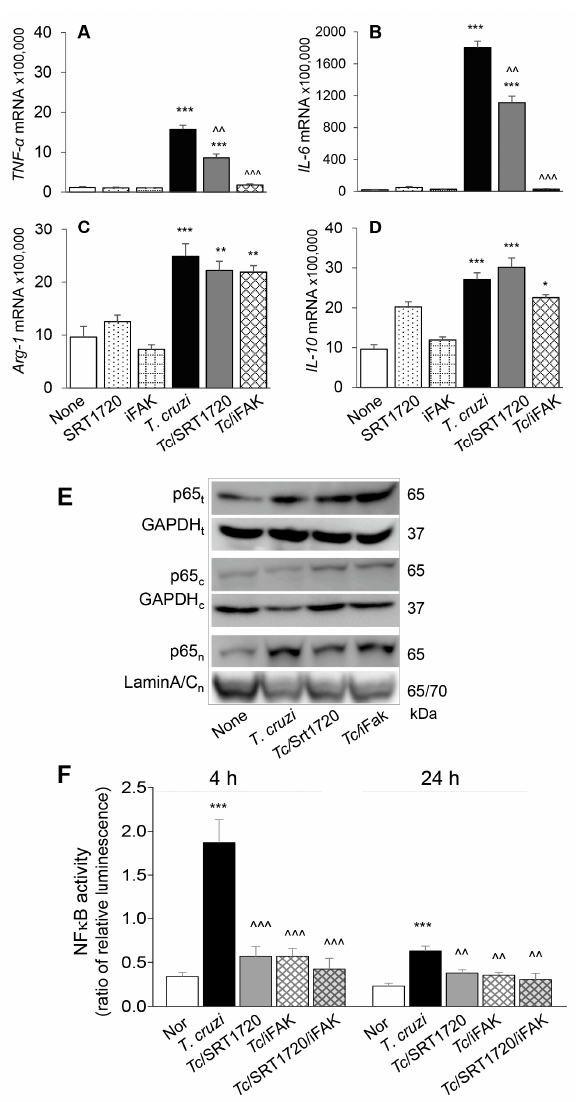
Figure 7. SIRT1-FAK (Sirtuin 1-focal adhesion kinase) regulate nuclear translocation of P65, NF- κ B activity, and cytokines’ gene expression in M ϕ infected by T. cruzi . ( A – D ) RAW 264.7 M ϕ were incubated for 24 h with T. cruzi trypomastigotes (cell parasite ratio, 1: 3) in absence or presence of SRT1720 (1 µ M) or inhibitor of FAK (iFAK, 10 µ M). Gene expression analysis of TNF- α (A), IL-6 ( B ), IL-10 ( C ) and Arg-1 ( D ) was performed by real-time RT-qPCR, and Ct values for target genes were normalized to GAPDH expression (three biological replicates per group, duplicate observations per sample). ( E ) RAW 264.7 M ϕ were infected and treated with SRT1720 or FAK inhibitor, as above. Shown are representative immunoblots for NF κ B p65 subunit in total (t) cell homogenates, and cytosolic (c) and nuclear (n) fractions of normal, infected, and infected / treated cells. GAPDH (cytosolic and total homogenates) and Lamin A / C (nuclear fractions) were analyzed as loading controls. ( F ) RAW 264.7 M ϕ were transfected with NF- κ B luciferase reporter and control renilla luciferase. Transfected cells were incubated with Tc ( ± SRT1720, FAK inhibitor) for 4 h and 24 h. Cells were then used in a Dual Luciferase (Firefly-Renilla) Assay, and the ratio of relative luminescence for firefly to renilla luciferase was calculated as a measure of NF- κ B activity. In all experiments, non-infected cells treated similarly with SRT1720 or iFAK were used as controls. Data in bar graphs are representative of two independent experiments (three biological replicates per treatment) and presented as mean ± SEM. Statistical significance in all bar graphs is plotted as * non-infected (N) vs. infected groups, ˆ Tc vs. Tc and SRT1720 and / or FAK inhibitor treatment. * p value < 0.05; ** or ˆˆ p value < 0.01; and *** or ˆˆˆ p value <